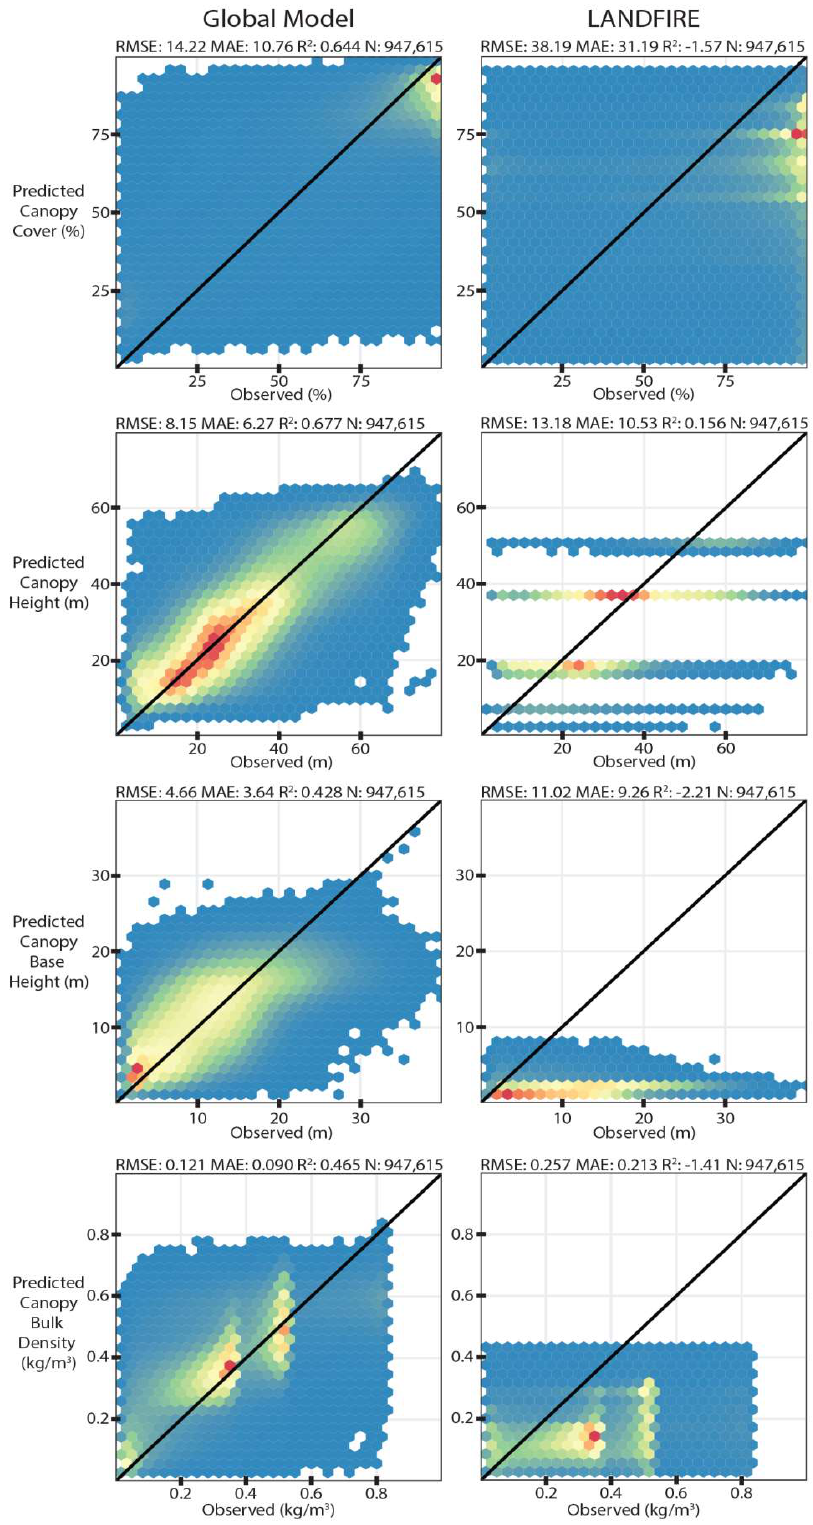
Figure 8. Predicted versus observed plots for the North Coast test landscape using the global GBM model ( left column ) and existing LANDFIRE layers ( right column ). Point density indicated with blue ( low ) to red ( high ) gradient.